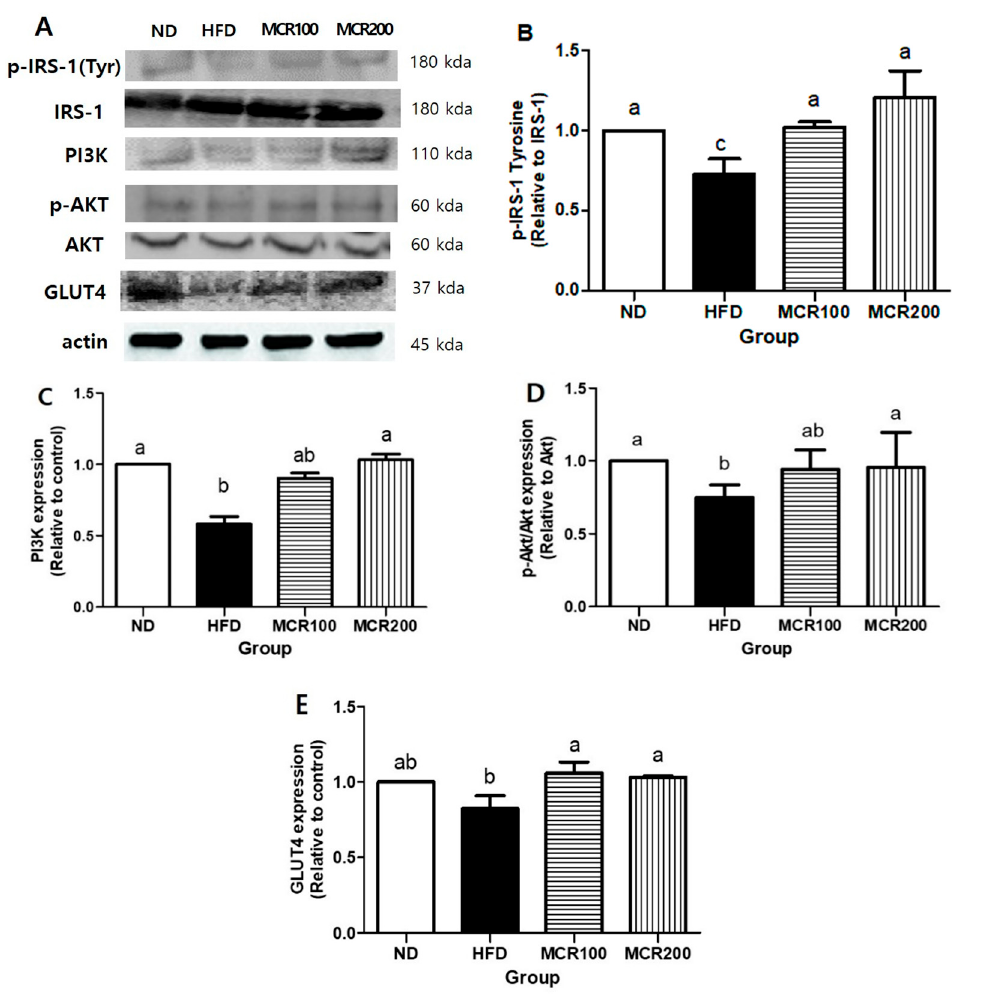
Figure 6. The effect of Mori Cortex radicis extract (MCR) on insulin receptor signaling in HFD-induced mice. Mice were fed ND or HFD with or without MCR (100 or 200 mg/kg b.w.) for 14 weeks. Protein levels in mouse brain tissues were determined by western blotting. ( A ) Representative western blots of p-IRS, PI3K, p-Akt, Akt, and GLUT4 in HFD mouse brains. Mice were fed ND or HFD with or without MCR (100 or 200 mg/kg. b.w.) for 14 weeks. Cerebral expression levels of ( B ) p-IRS, ( C ) PI3K, ( D ) p-Akt, and ( E ) GLUT4. Results are presented as means ± SDs ( n = 8). Statistical significance was accepted for p values < 0.05. Small letters indicate significantly different from other groups.